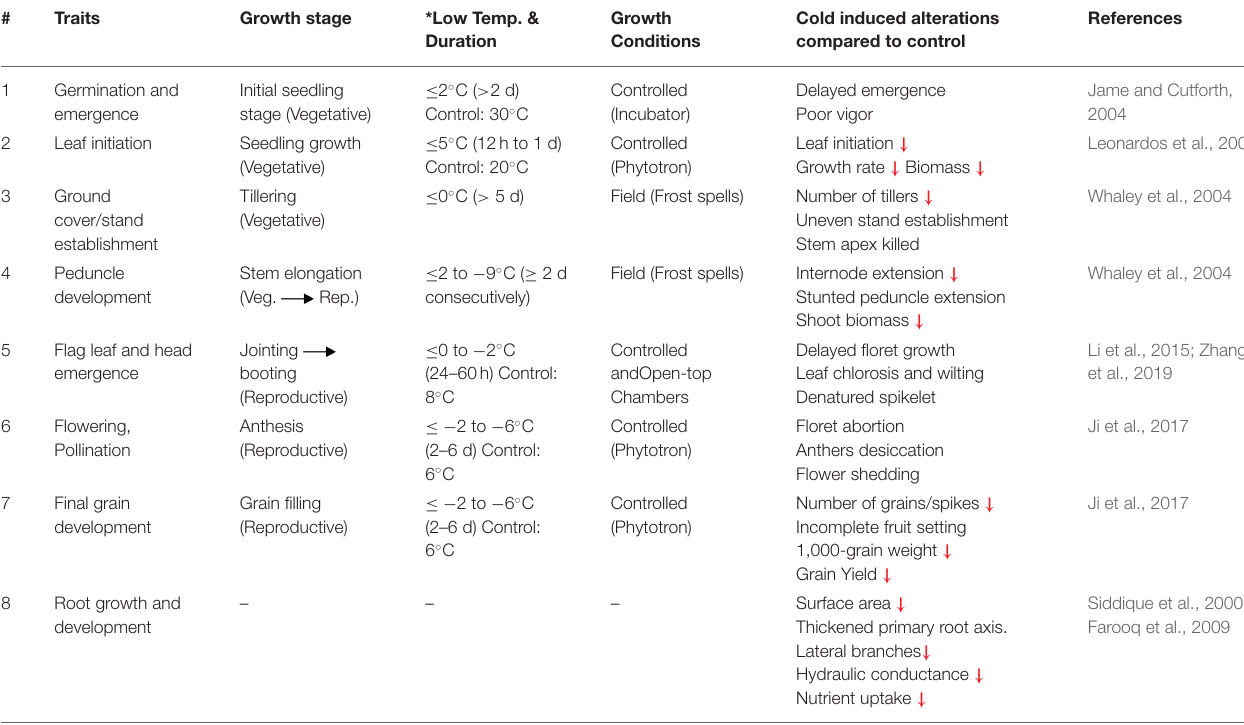
TABLE 2 | Morphological traits of wheat with respect to their growth stages, influenced by cold